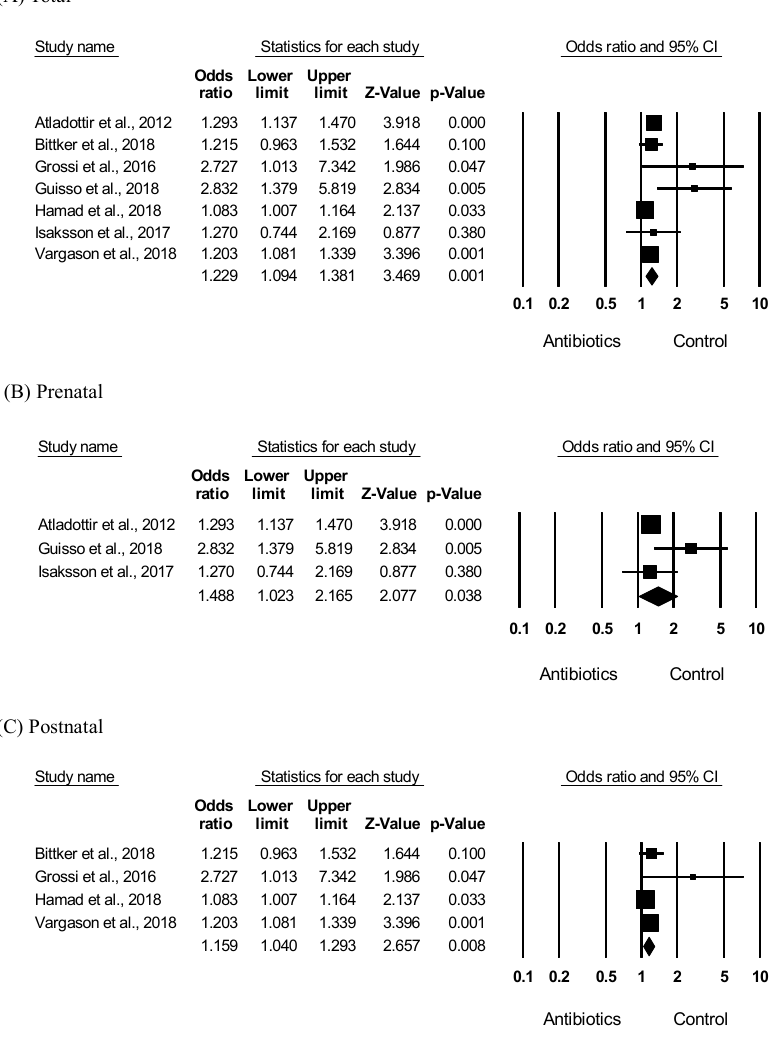
Figure 2. Meta-analysis of the odds ratio estimate of ASD risk according to antibiotic exposure in children. E ff ects sizes are measured as odds ratio in the antibiotic exposed group compared to that in the control group. ( A ) Forest plot of the ASD risk in early (pre- and postnatal) antibiotic exposure. Heterogeneity, Q = 15.669, p = 0.016, I 2 = 61.709 ( B ) Forest plot of the ASD risk in prenatal